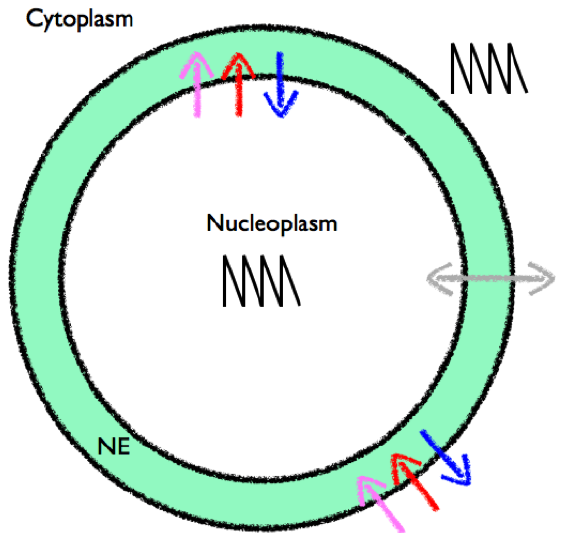
Figure 3. Schematic of the possible signalling components during symbiosis. Calcium can be released from the nuclear envelope (NE) into either the cytoplasm or the nucleoplasm via calcium release channels (blue). Calcium is actively removed from the volume back into the NE through the action of calcium pumps (red). Other transporters, such as a K + channel, may be involved in voltage regulation (pink). Passage of calcium ions between the interior and exterior of the nucleus may be possible through the nuclear pores